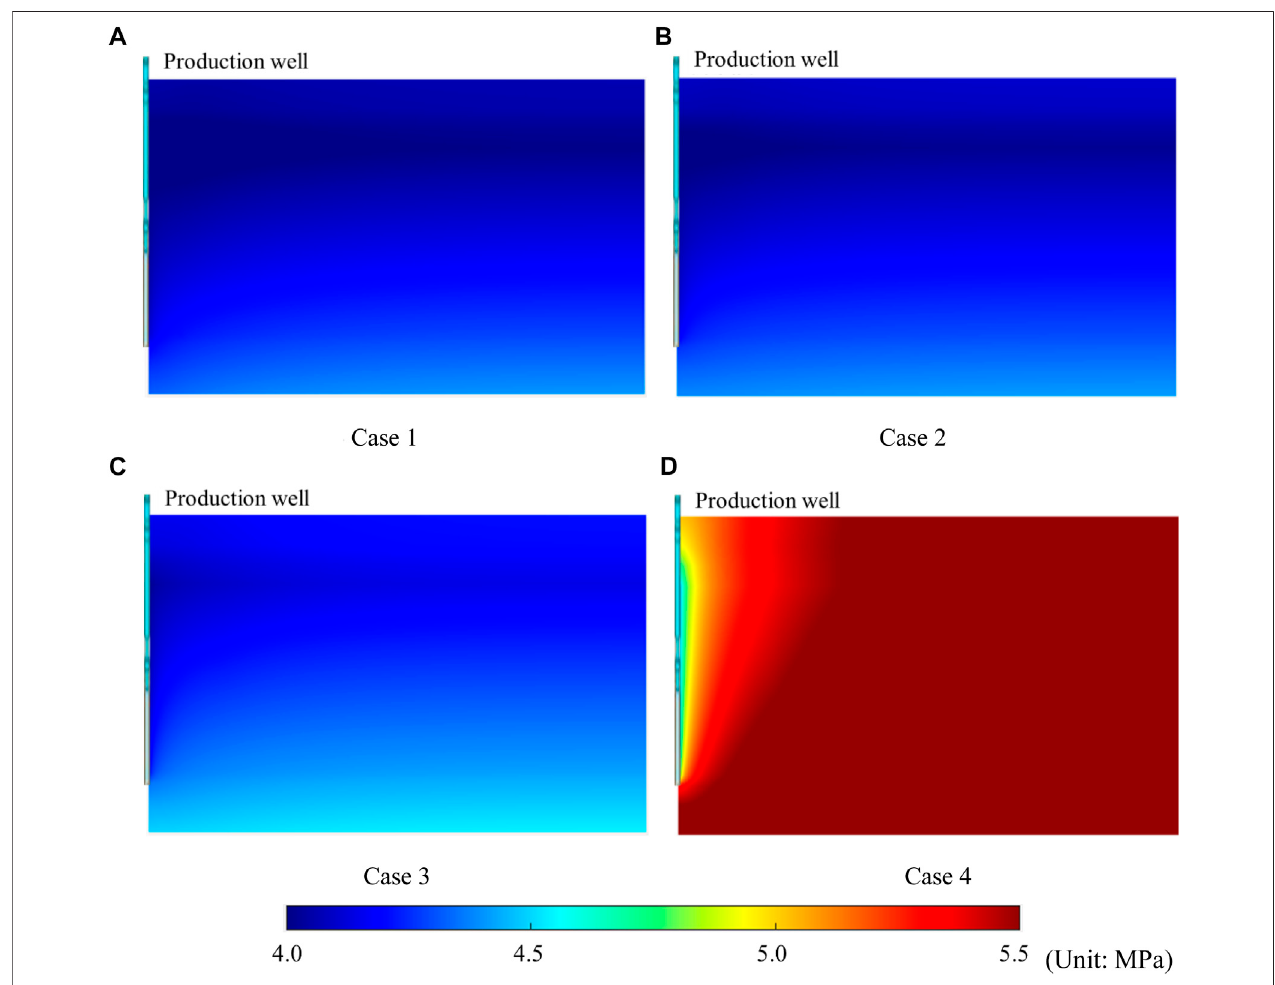
FIGURE 8 | Pressure distribution of each case. (A) Case 1. (B) Case 2. (C) Case 3. (D) Case 4.